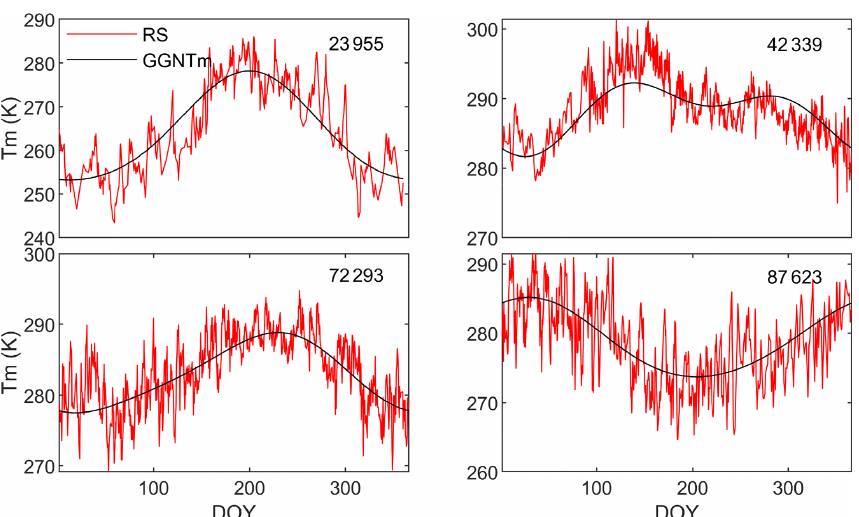
Figure 6. T m values (at the earth surface) integrated from the radiosonde measurements as well as that predicted by GGNTm at each of the four radiosonde stations (nos. 23955, 42339,72293, and 87623).